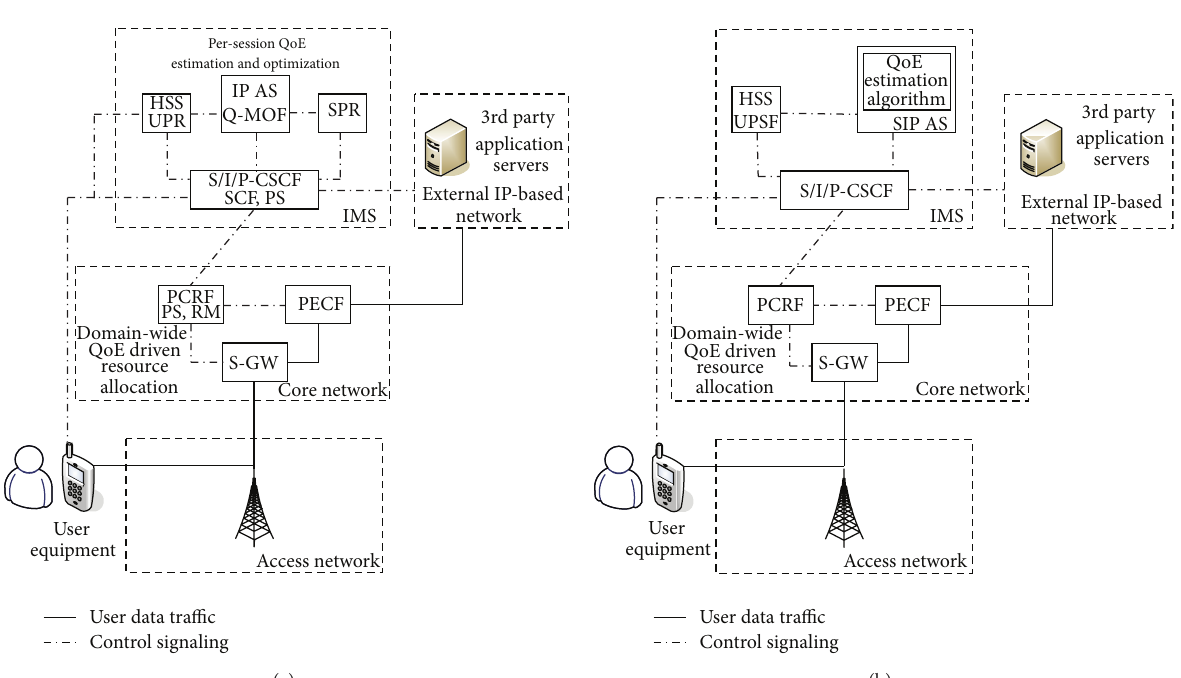
Figure 5: QoE control mechanisms: (a) Skorin-Kapov and Matijaˇsevi´c [100] and Iveˇsi´c et al. [101]; (b) Sterle et al. [102] (see